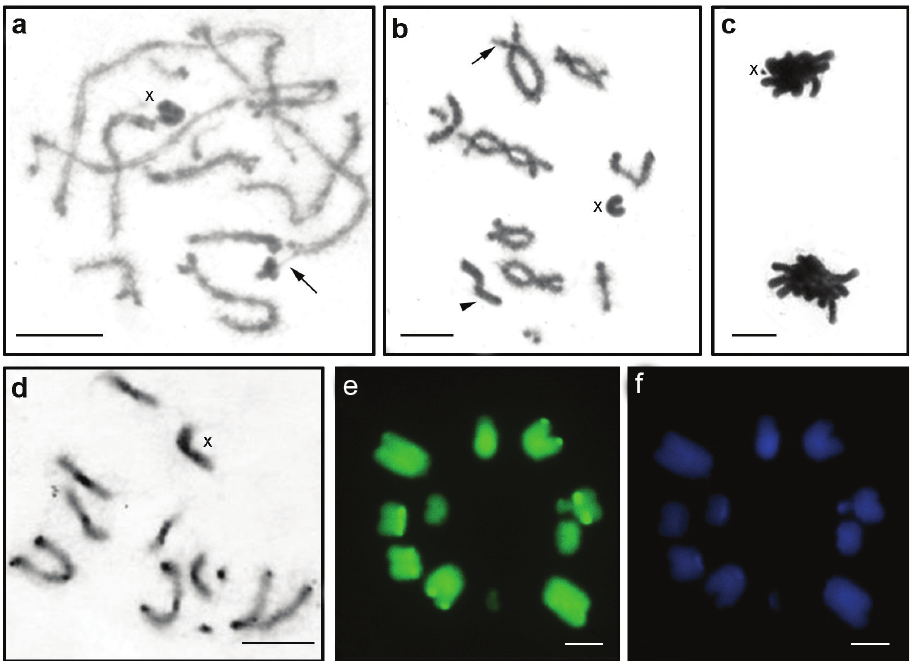
Figure 4. Meiotic stages of T. cristata grandis . a pachytene with positively heteropycnotic X chromosome b diplotene/diakinesis c two daughter cells at anaphase I with visible X chromosome in one of them d C- banding with pericentromeric and terminal blocks of heterochromatin in most chromosomes and posi- tively heteropycnotic X chromosome e CMA staining f DAPI staining. Arrows and arrowheads indicate 3 secondary constrictions and the megameric chromosome respectively. Bar = 10